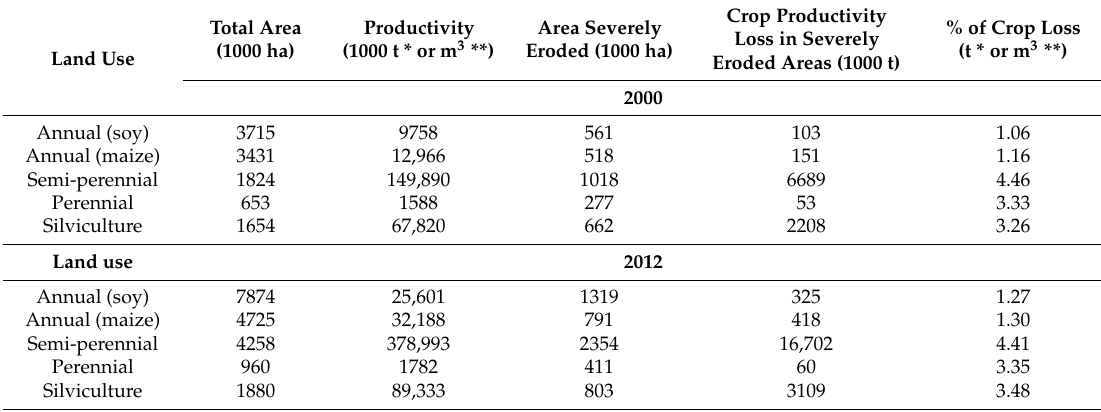
Table 9. Estimated productivity loss for crops and silviculture in the Brazilian Cerrado in 2000 and